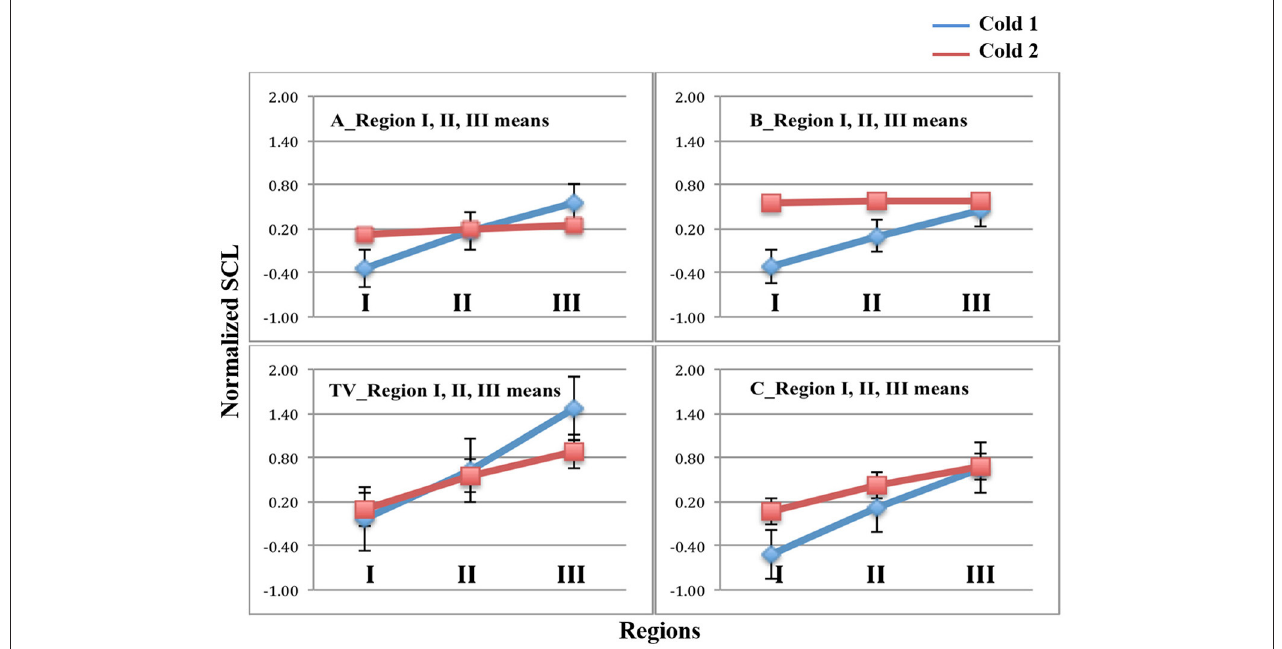
FIGURE 4 | Mean and standard error bars of normalized SCL in Regions I, II, and III. Blue = Cold1. Red = Cold2. Data are from the four limb sensors for n = 23 participants. Analgesics were applied in A and B, and are associated with a lack of increase across the Cold2 pressor.